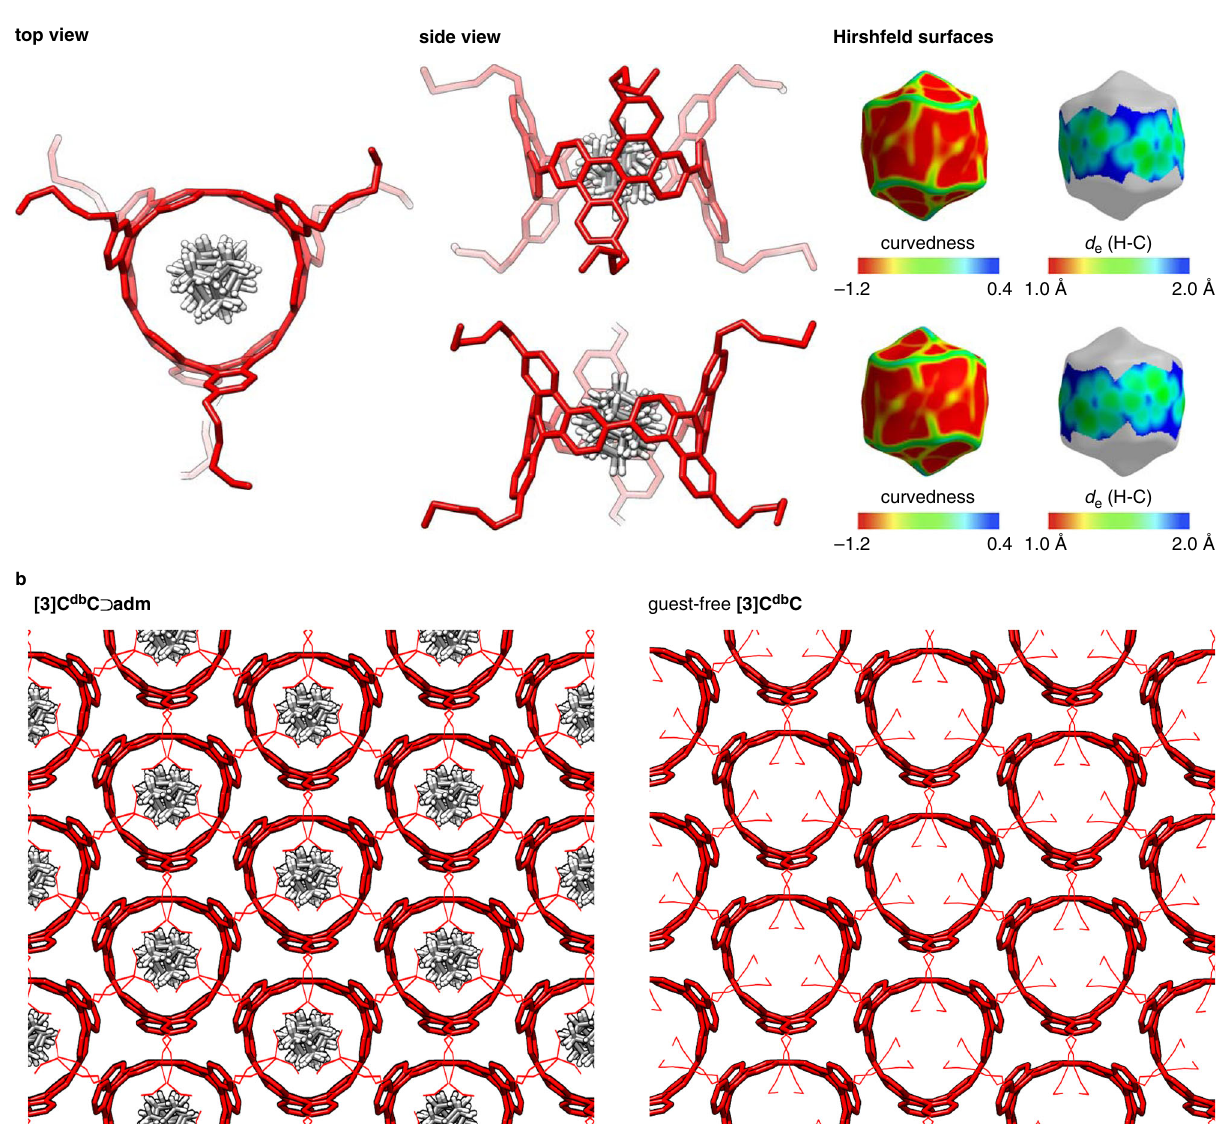
Fig. 3 Crystal structures of a hybrid nanocarbon peapod. a Molecular structures and Hirshfeld surface analyses of encapsulated adm molecules. Solvent molecules, minor alkyl conformers, and hydrogen atoms of [3]C db C are omitted for clarity. Solvent molecules had no direct contact with the adm guest (see also Supplementary Fig. 11). The details of the disordered structures are shown in Supplementary Figs. 7 and 8. b Packing structures of [3]C db C ⊃ adm and guest-free [3]C db C . When the two panels shown in b are viewed as an autostereogram, one may easily notice that the crystal structures of cylinders are unaffected by the introduction of adm